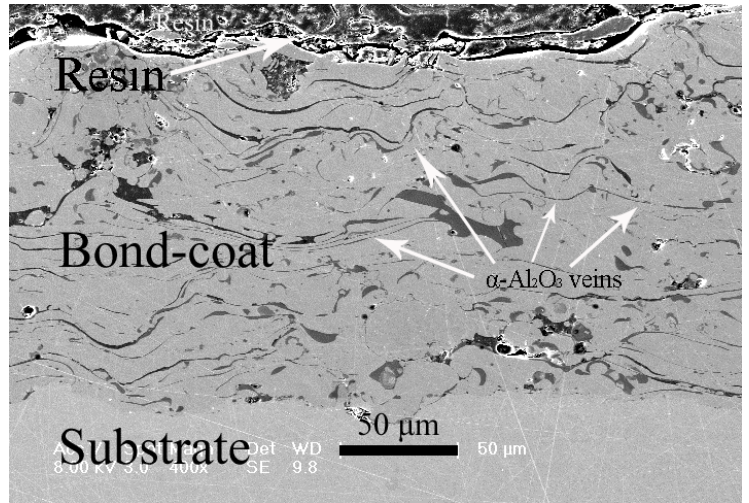
Figure 1. Cross-sectional morphology of the as-sprayed APS bondcoat.